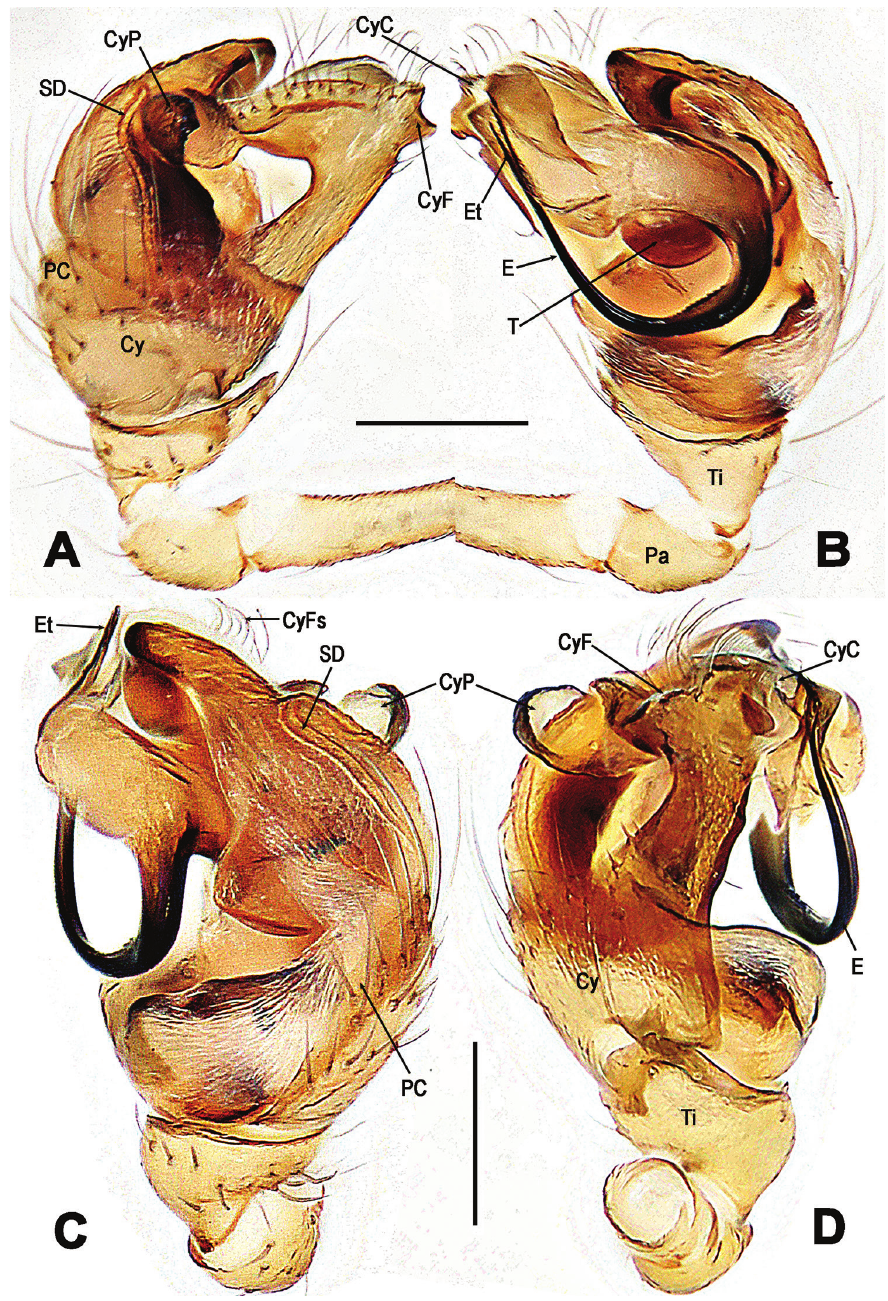
Figure 10. Trogloneta yunnanense (Song & Zhu, 1994) comb. n., male left palp ( A–D ). A prolateral B retrolateral C dorsal D ventral. Abbreviations: Cy cymbium; CyC cymbial conductor; CyF cymbial fold; CyFs setae on cymbial fold; CyP cymbial process; E embolus; Et embolic tip; TA tegular apophysis; Pa patella; PC paracymbium; SD spermatic duct; T tegulum; Ti tibia. Scale bars: 0.20